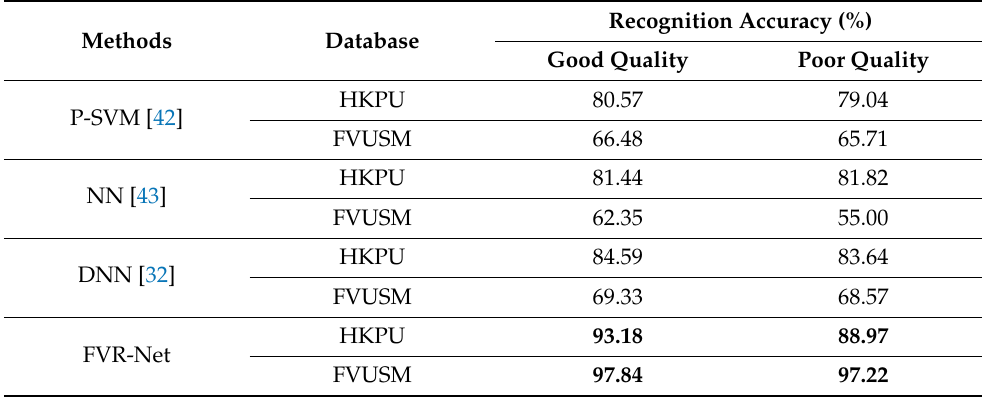
Table 5. Comparison of Recognition Accuracy from FVR-Net with Several Baseline Finger Vein Recognition